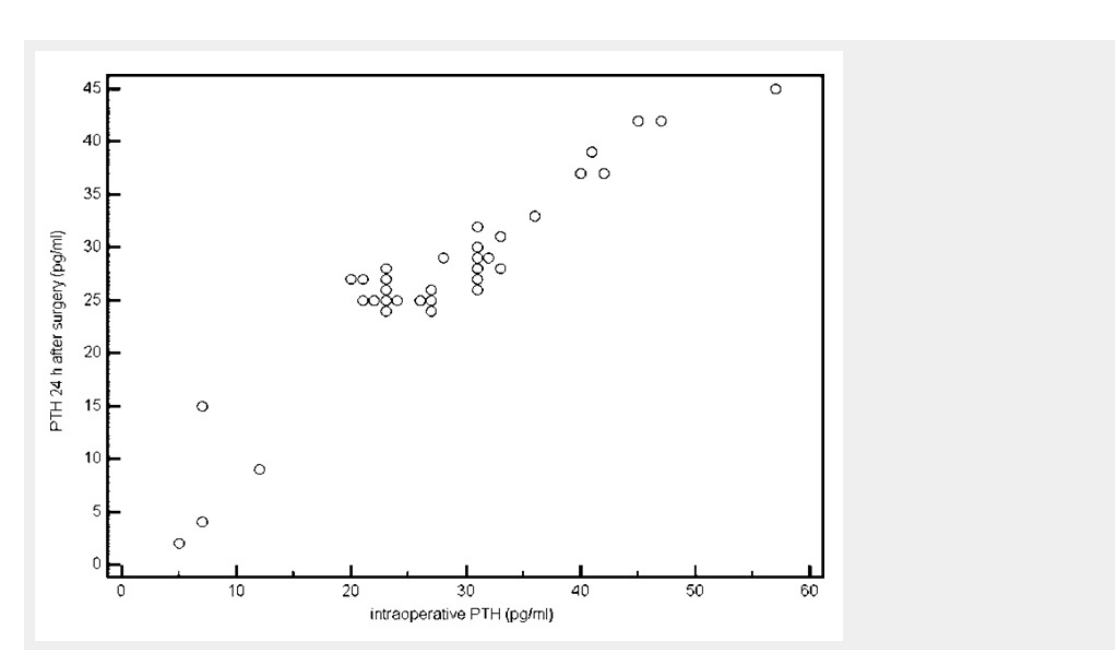
Figure 1 Scatter plot for correlation between intraoperative rapid PTH assay and standard PTH assay taken 24 hours after surgery. Correlation coefficient = 0.95 (P < 0.001).